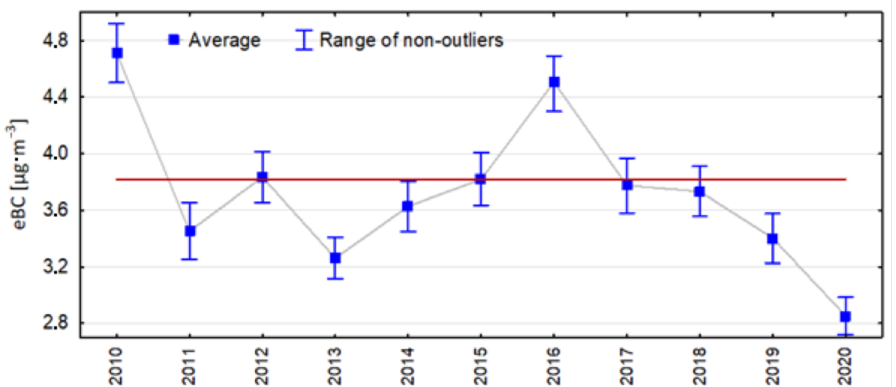
Figure 2. The chart of mean and non-outlier eBC concentrations at the urban background station in Zabrze (2010–2020